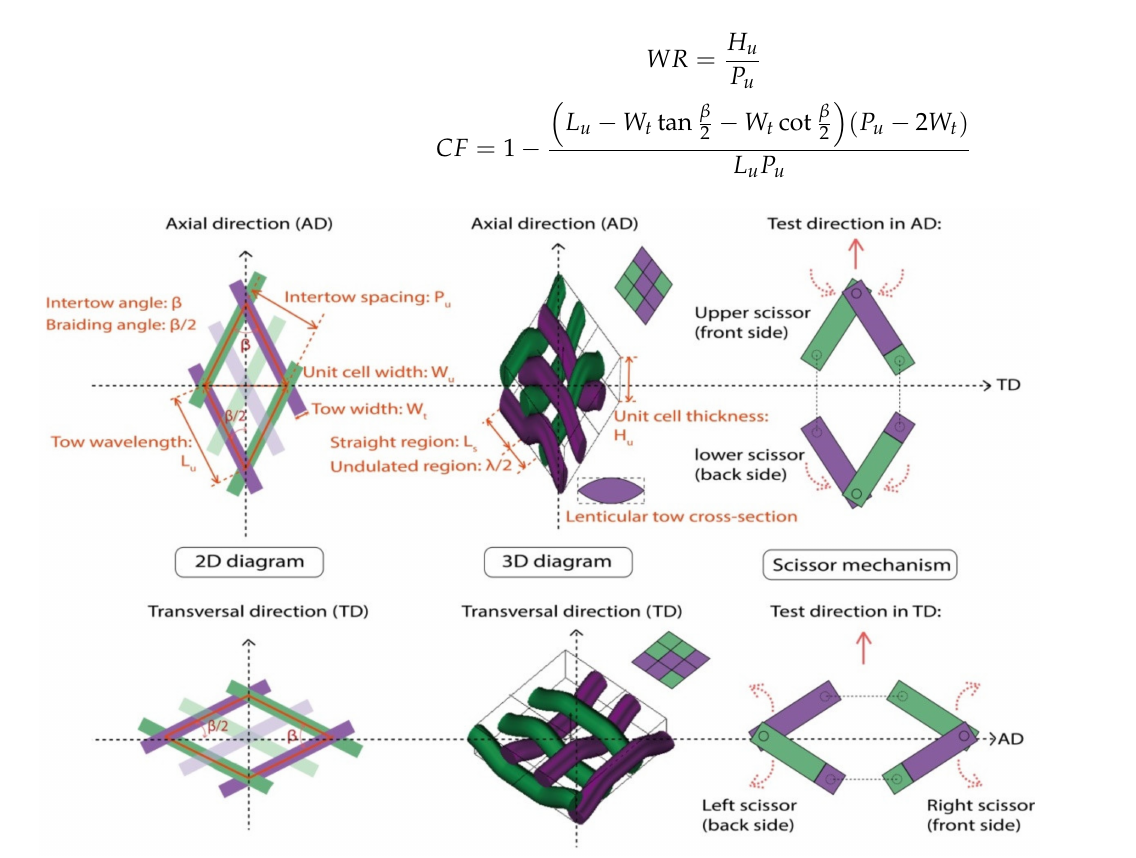
Figure 2. Unit cell geometry of 2D biaxial braids: test direction in AD and